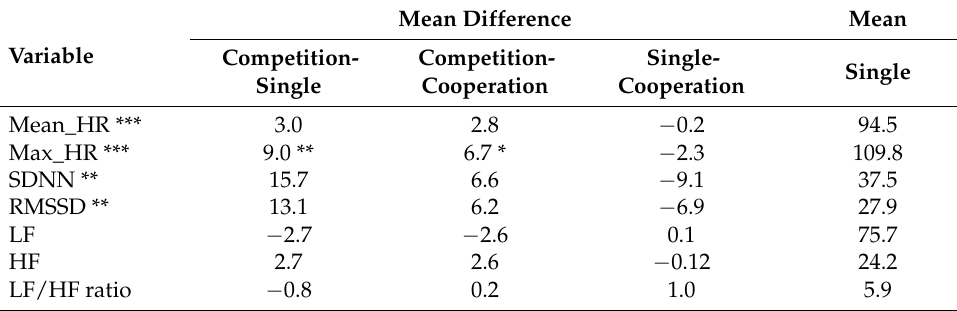
Table 6. Multiple comparison of effects of gameplay modes on ECG